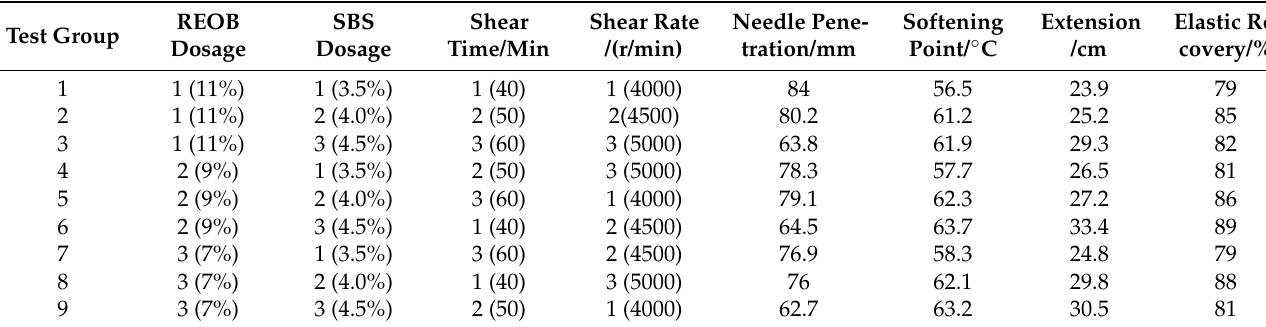
Table 8. Orthogonal test